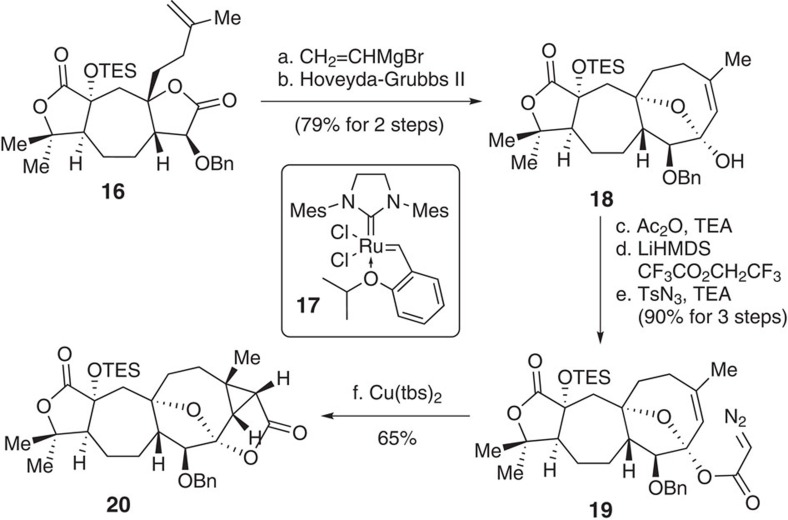
Synthesis of the lactone 20.(a) Grignard reagent (1.5 eq), THF, rt; (b) Hoveyda-Grubbs II (17, 0.05 eq), PhMe, 80 °C, 79% in two steps; (c) Ac2O (2.0 eq), DMAP (0.5 eq), Et3N (5.0 eq), DCM, rt, 97%; (d) LiHMDS (2.5 eq), CF3CO2CH2CF3 (1.5 eq), THF, −78 °C to 0 °C. (e) TsN3 (1.4 eq), Et3N (3.0 eq), MeCN, rt, 93% in two steps; (f) Cu(tbs)2 (0.1 eq), PhMe, 80 °C, 4.5 h, 65%. ; Cu(tbs)2, bis(N-tert-butylsalicylaldiminato) copper(II); DMAP, 4-dimethylaminopyridine; TsN3, tosylazide.